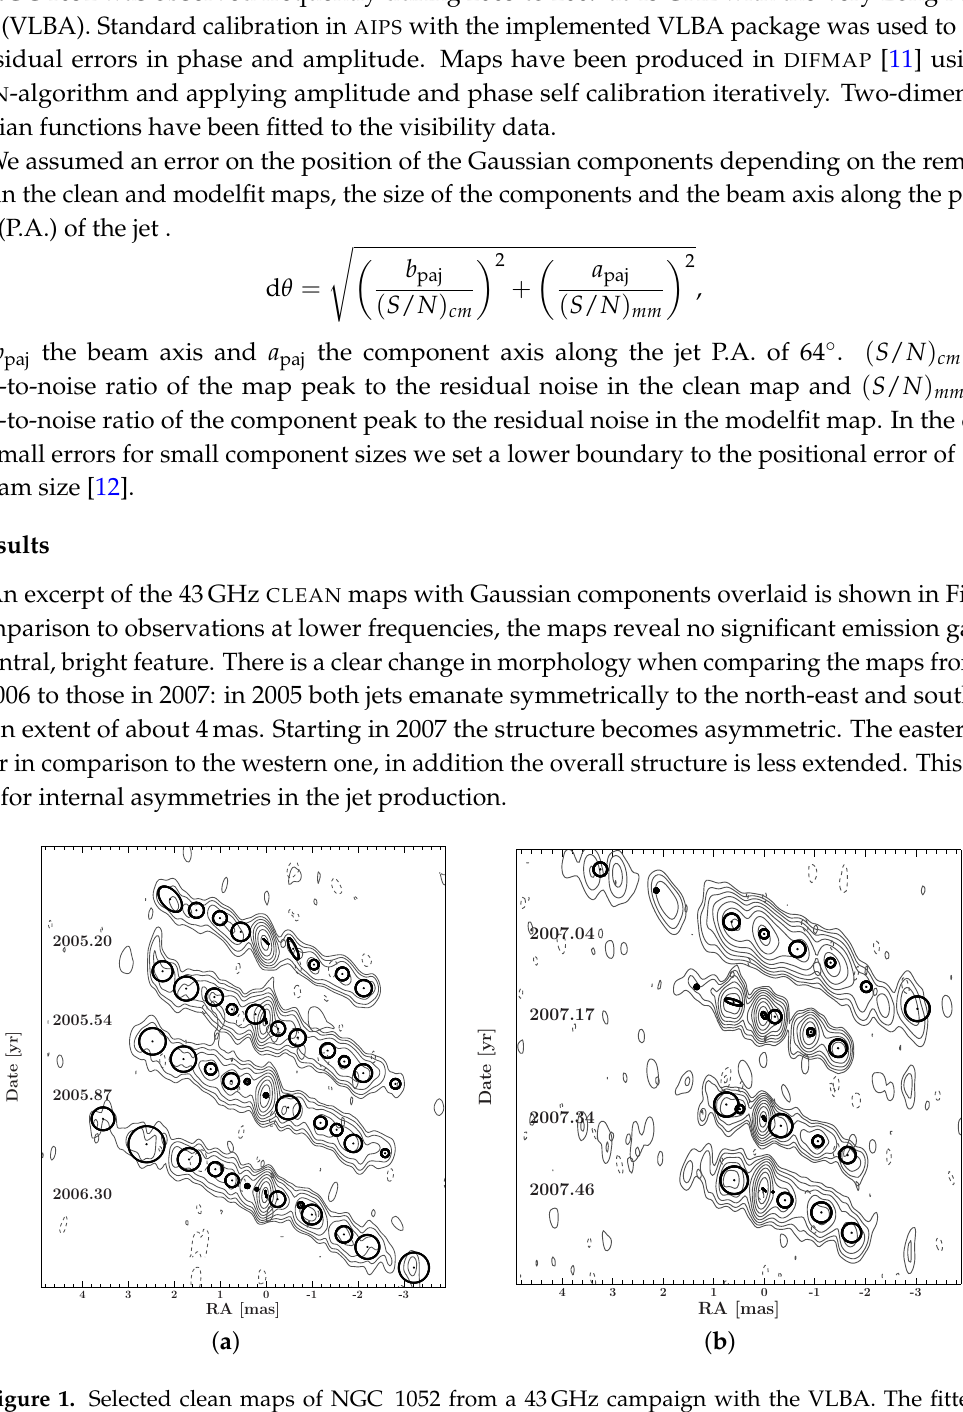
Figure 1. Selected clean maps of NGC 1052 from a 43GHz campaign with the VLBA. The fitted two-dimensional Gaussian functions are plotted on top of the clean contours. ( a ): maps from 2005 showing highly symmetric jets, with one bright central feature; ( b ) maps from 2007; the jets are shorter and asymmetric. Map parameters are shown in Table 1. The contour lines begin at three times the noise level (see column 3 in Table 1) increase logarithmically by a factor of